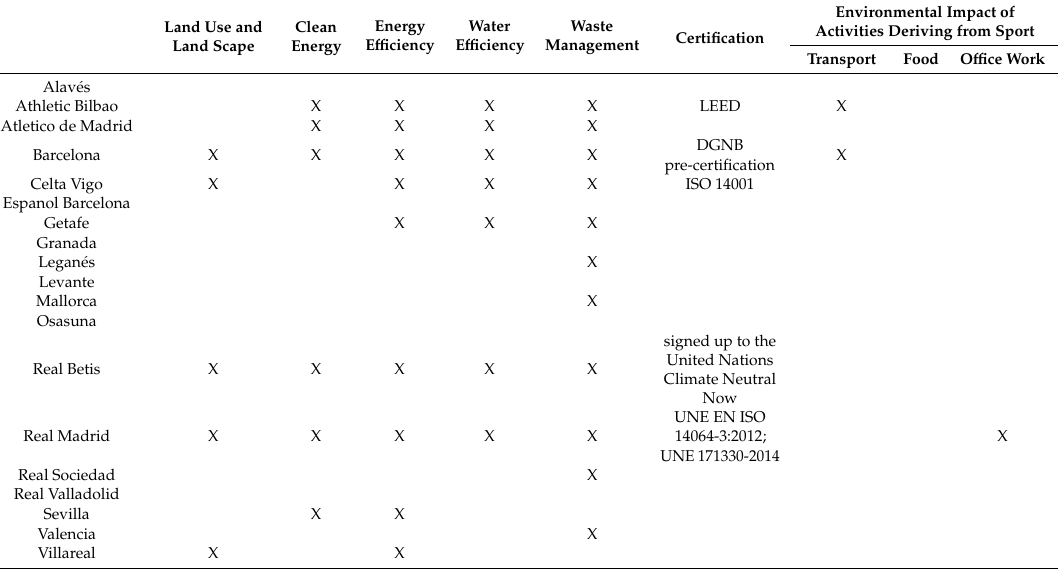
Table 4. Environmental activities by the clubs of the La